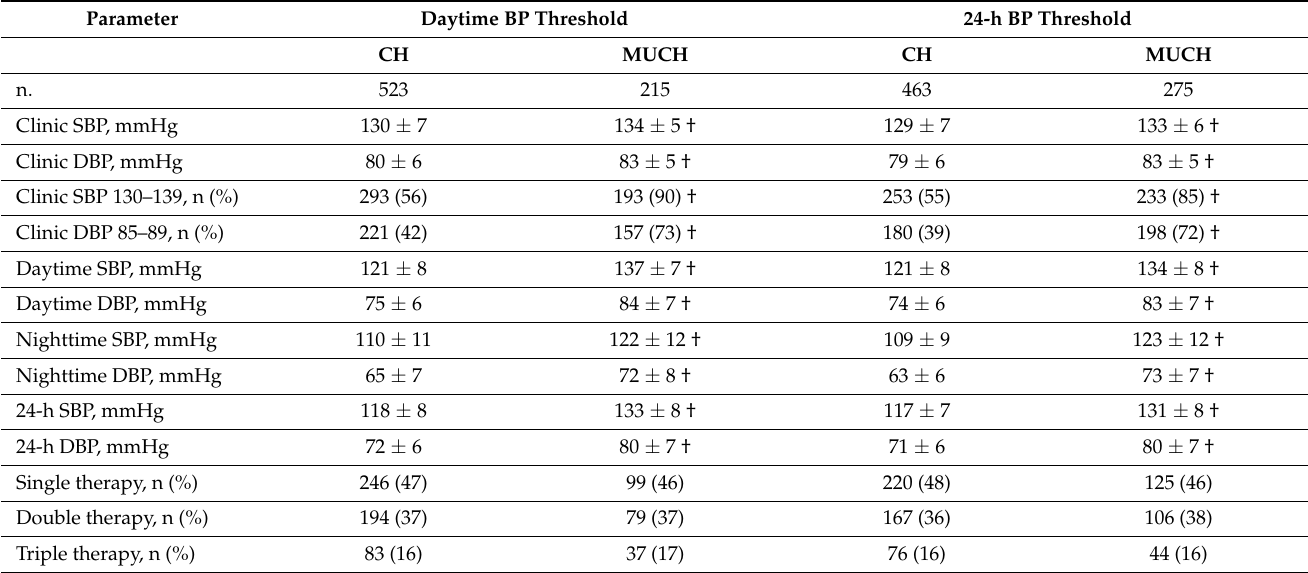
Table 2. Blood pressure values and therapeutic strategy of study groups.